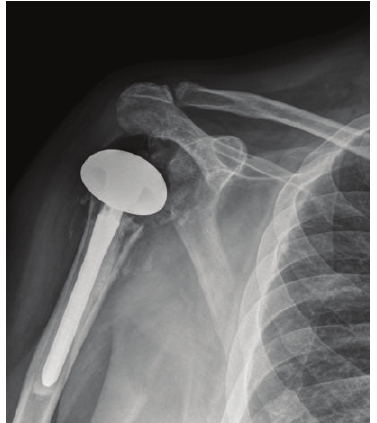
Figure 3: Radiograph showing the hemiarthroplasty.